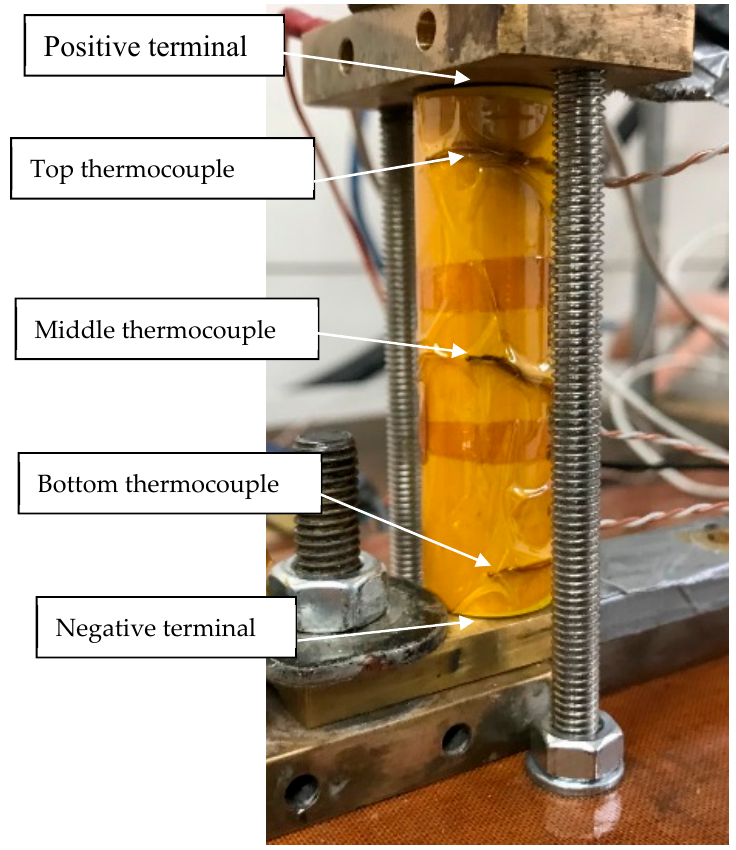
Figure 11. Cell failure testing setup showing thermocouple location.